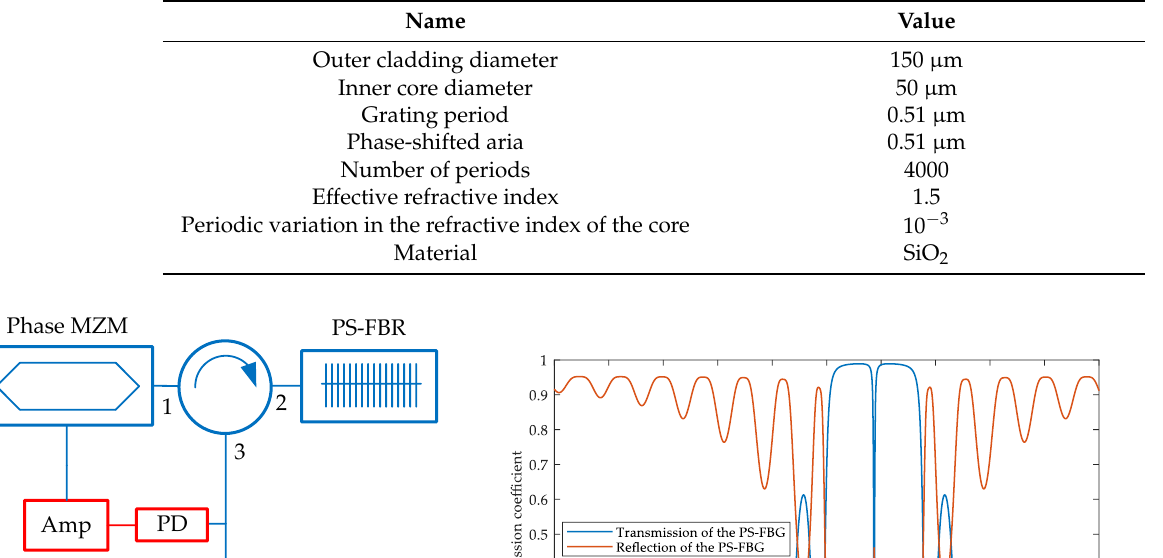
Table 2. PS-FBG sensor parameters. Figure 16. Relative power at the interrogator drop port versus the resonant wavelength of the FBG: ( a ) for the scheme that analyzes the transmitted light; ( b ) for the scheme that analyzes the reflected light.